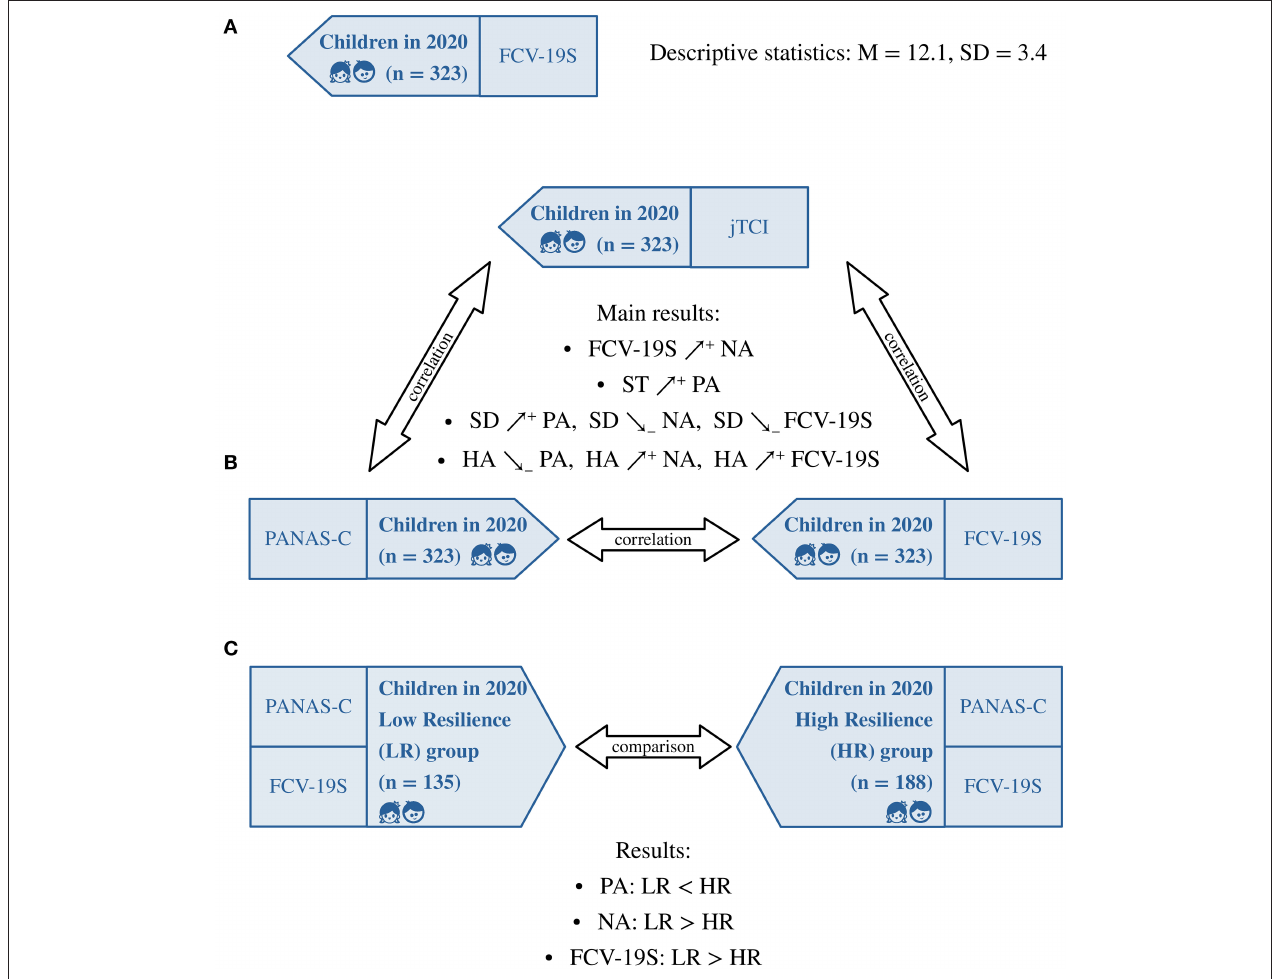
FIGURE 2 | Secondary analyses of the study. (A) Descriptive statistics of FCV-19S scores. (B) Correlation of PANAS-C, FCV-19S and jTCI scores collected during the pandemic. (C) Comparison of PANAS-C and FCV-19S scores collected during the pandemic between a Low-Resilience and a High-Resilience personality profile group (the two groups were obtained partitioning the whole study sample on the basis of individuals’ HA and SD scores from the jTCI questionnaire). PANAS-C, Positive And Negative Affect Scale for Children; PA, Positive Affect; NA, Negative Affect; FCV-19S, Fear of COVID-19 Scale; jTCI, junior Temperament and Character Inventory; HA, Harm Avoidance; SD, Self-Directedness; ST, Self-Transcendence; ր + , positive correlation; ց − , negative